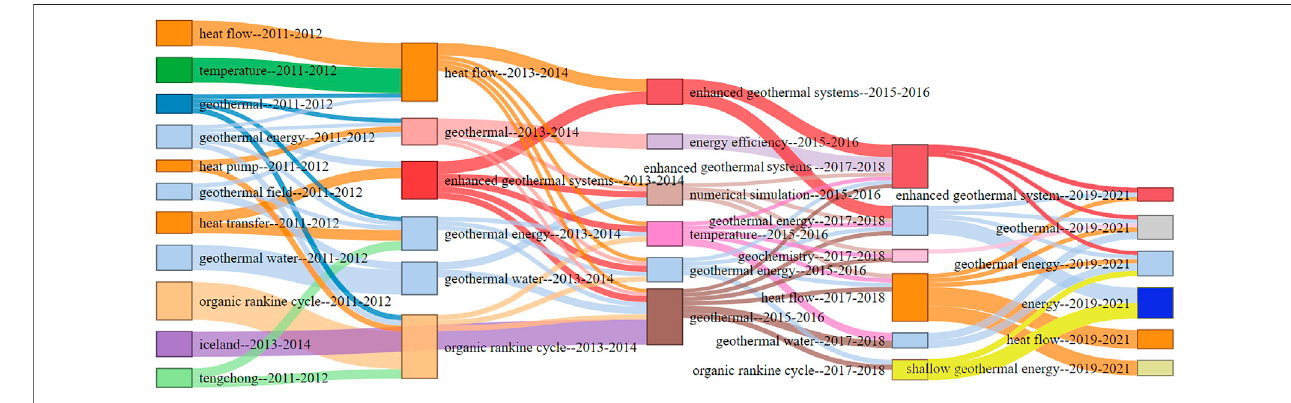
FIGURE 10 | Thematic evolution structure of geothermal.